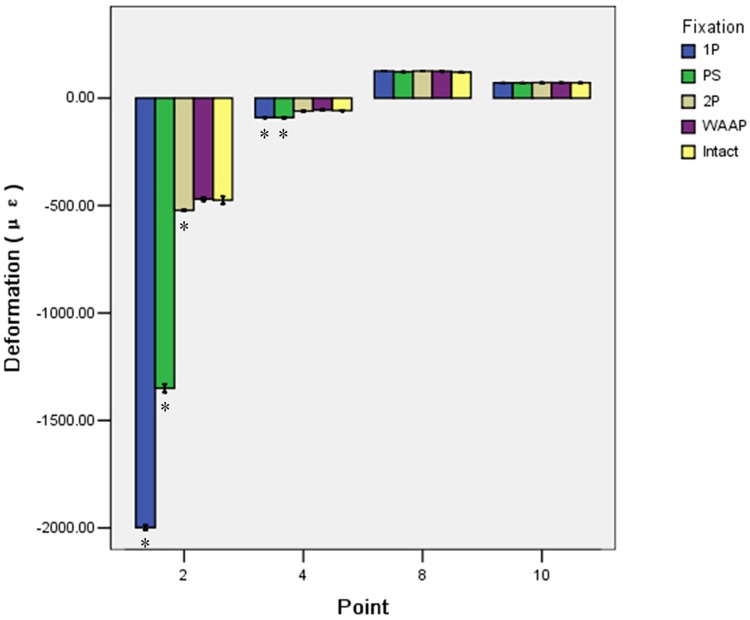
Mean deformations for the four different constructs compared with the intact state.There were significant differences from the intact condition in both the superior (point 2) and interior (point 4) regions. * Different from intact (p<0.05).